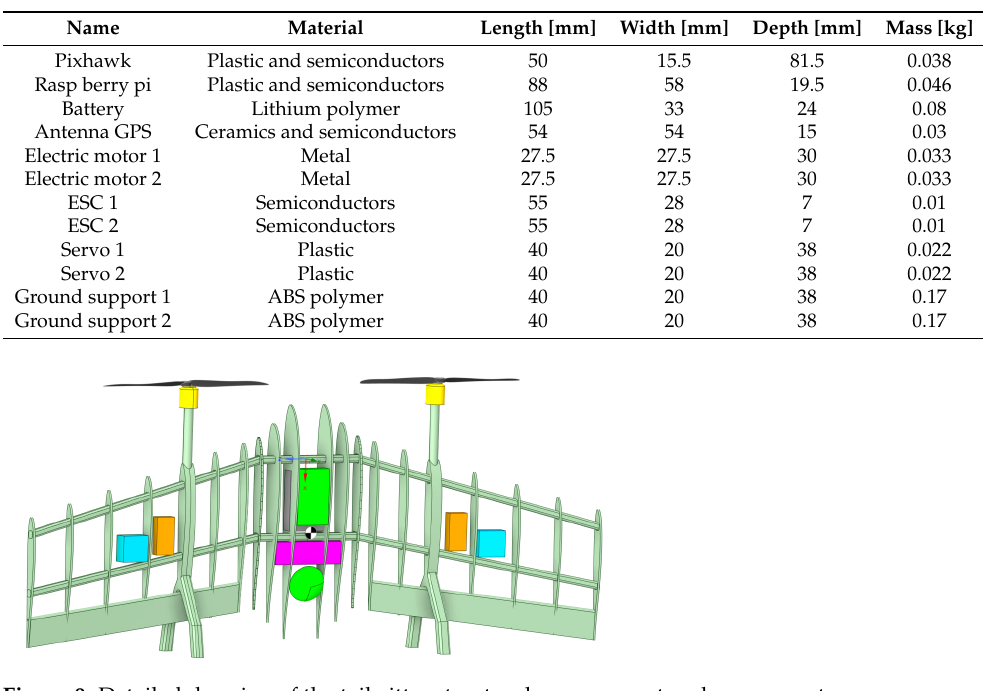
Figure 9. Detailed drawing of the tail-sitter structural arrangement and